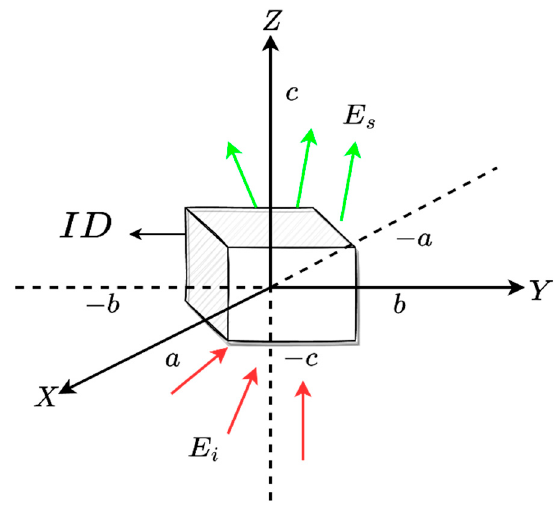
Figure 2. The geometry of a cube ID.